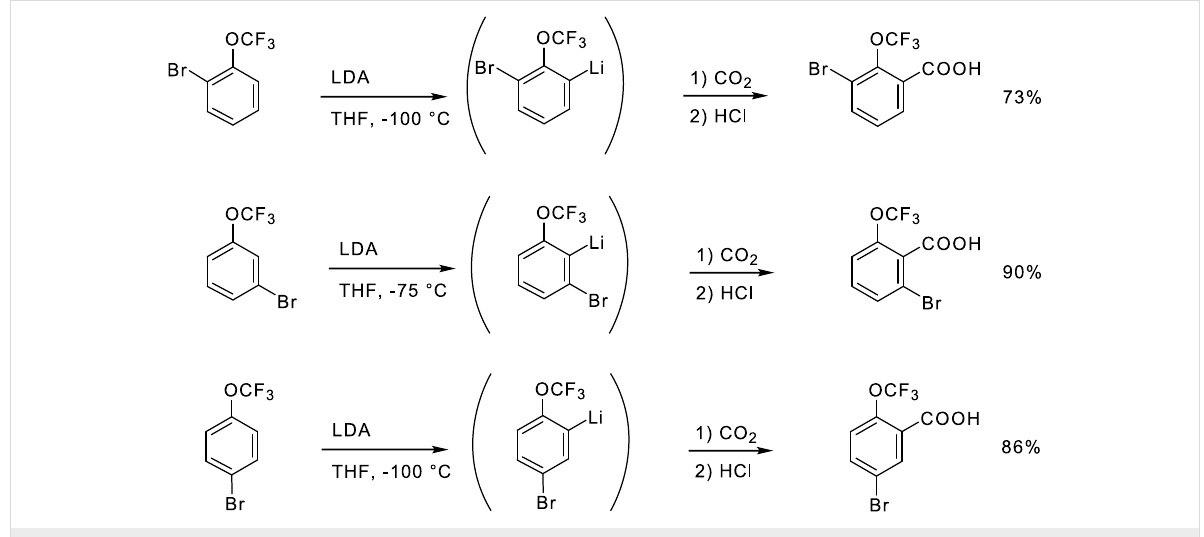
Scheme 18: Metalation of Bromo(trifluoromethoxy)benzenes.